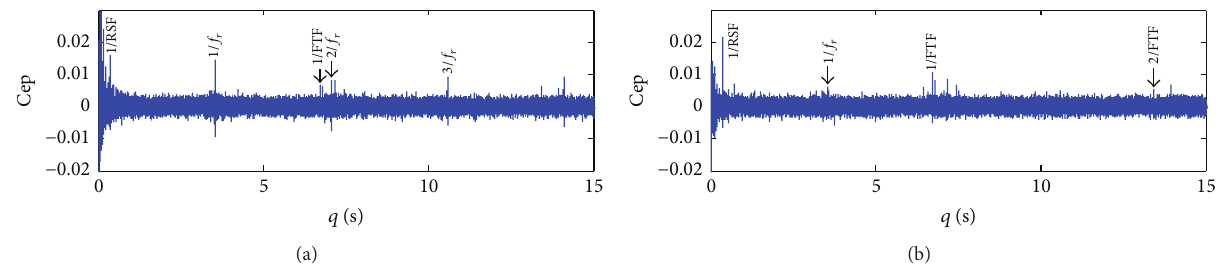
Figure 16: Cepstrum of vibration signals in chn08 and chf08. (a) Normal and (b) fault.